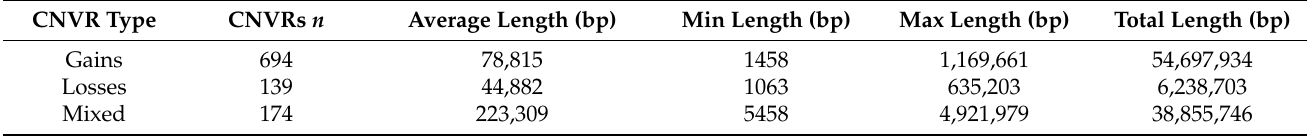
Table 2. Summary of regions CNVs in Pura Raza Española